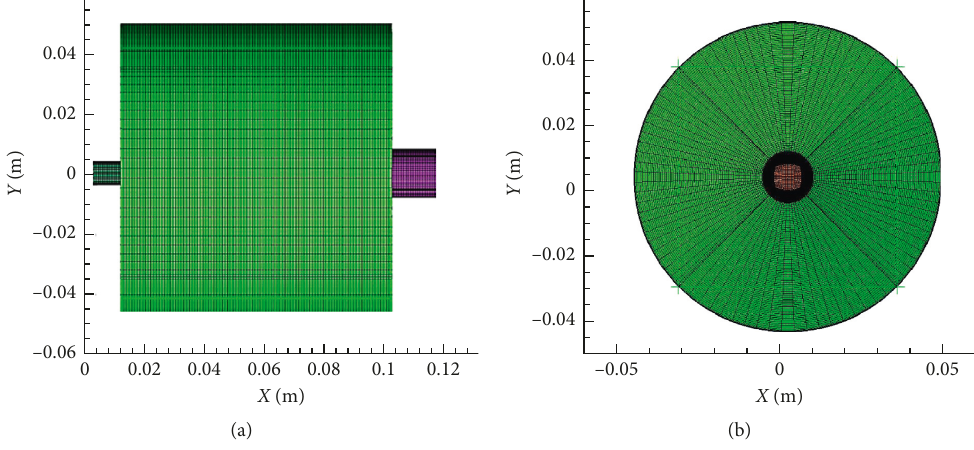
Figure 3: Division diagram for modeling mesh.